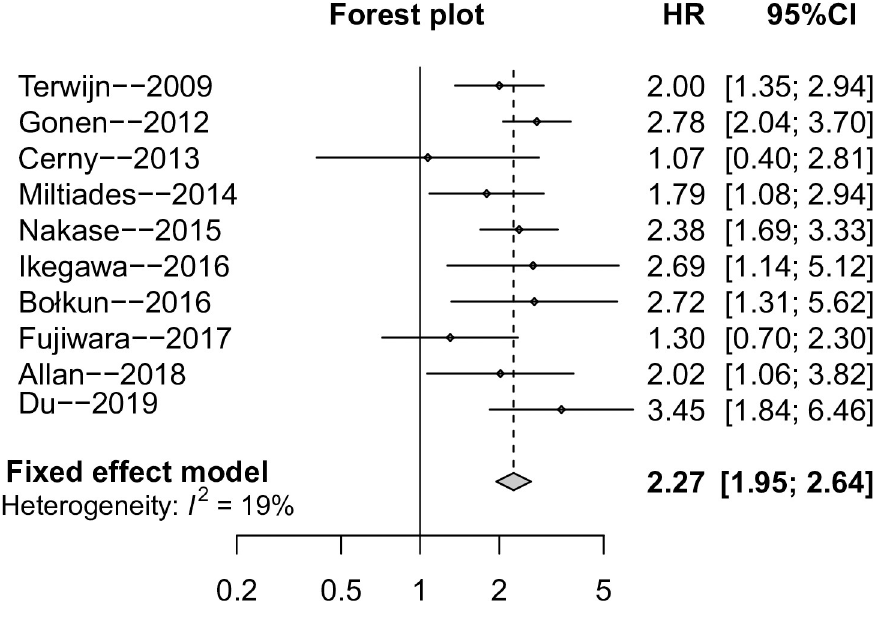
Fig 2. Forest plot for overall survival (OS) outcome of CD25 expression in AML patients.